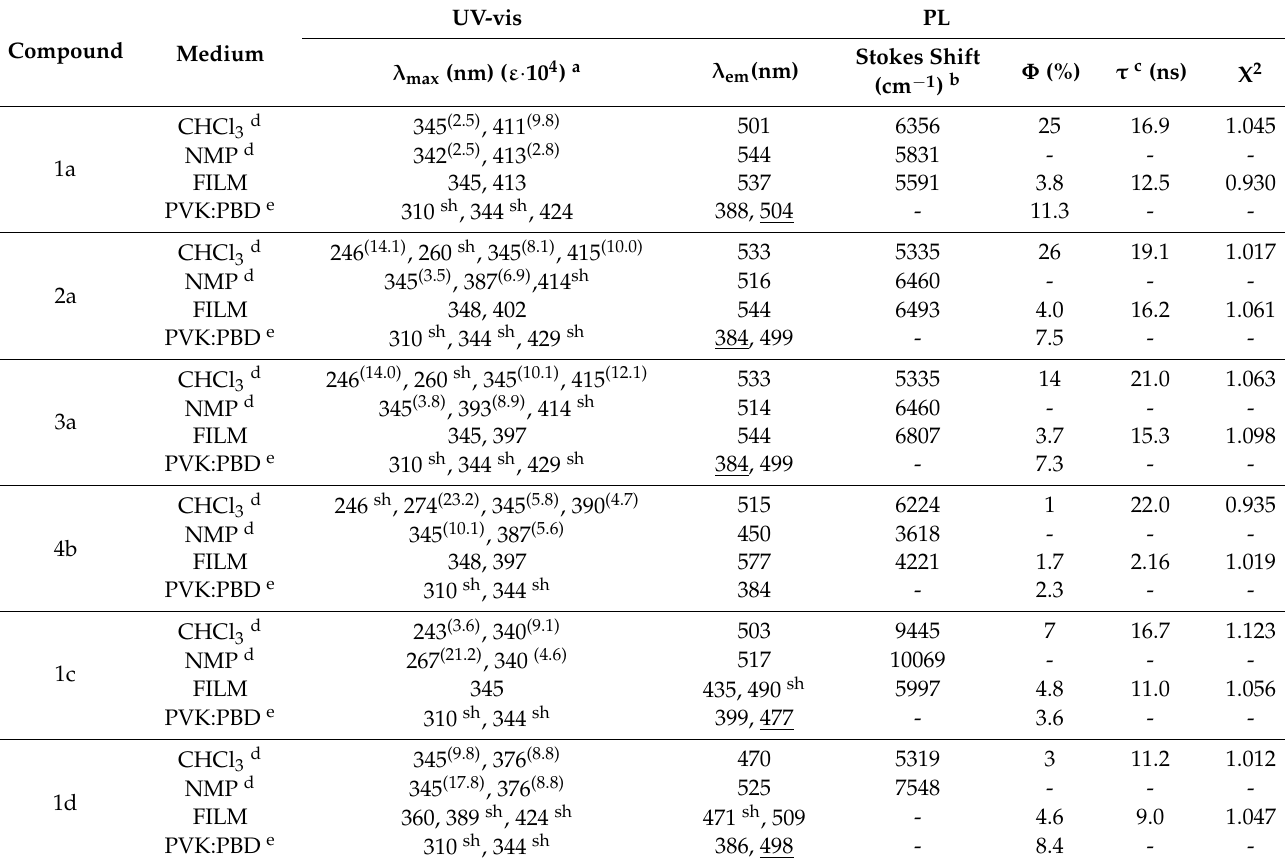
pound with the biphenyl core (1c) in solutions were noticed ( ∆ λ max = 35 nm) (Table 4). No differences in λ max position between molecules with TPA core in chloroform solution were seen, however, dissimilarities were recorded in emission spectra. The hypsochromic shift of λ λ λ max of molecules with benzyl (2a, max = 387 nm) and 4-methylbenzyl (3a, max = 397 nm) attached to the nitrogen in the imide ring compared to 1a with hexyl chain ( λ max = 413 nm) registered in NMP was seen. Table 4. Collected UV-Vis and PL properties of bis-(imino-1,8-naphthalimides).